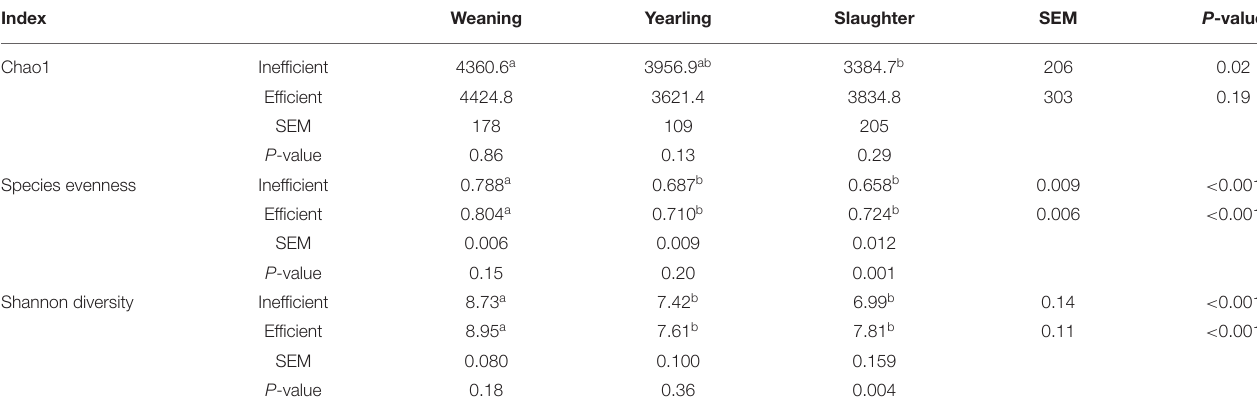
TABLE 2 | Alpha-diversity indices calculated for the fecal samples of efficient and inefficient steers at different stages of their lives: weaning, yearling, and kill floor (slaughter).